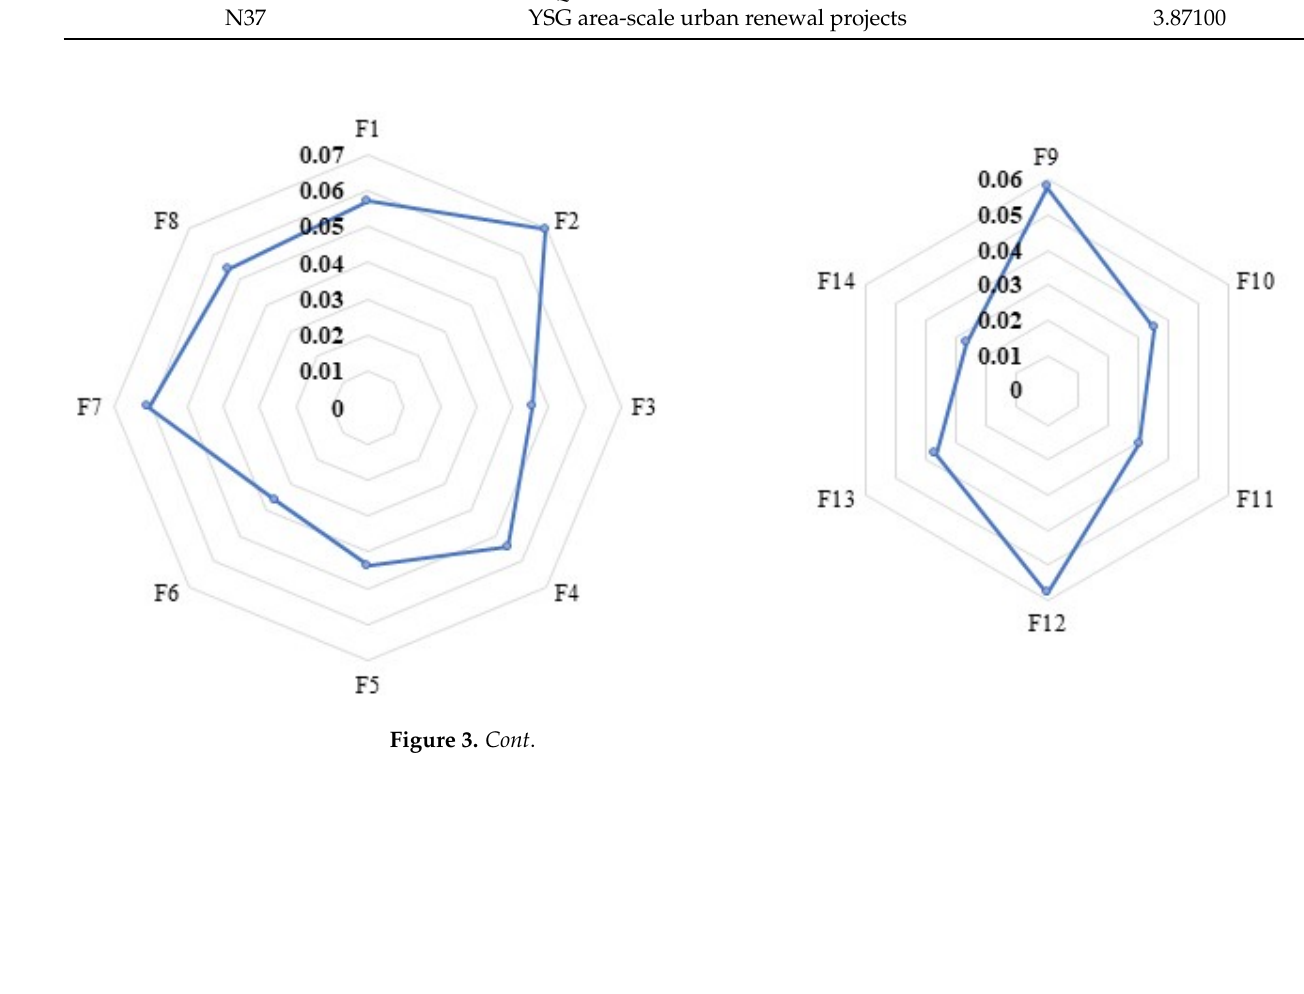
Figure 3. The final weights of each indicator. In summary, through the BP neural network model, the final weight value of the evaluation indicator under each dimension is obtained, and the error is within the control range, indicating that the operation effect of the model is satisfactory. Thus, the BP neural network can optimize the results of the entropy weight method to make its indicator weight results more accurate. The final weight value of the indicator obtained by the BP neural network is used to calculate the final comprehensive benefit values of the renewal initiatives on the area scale, which are summarized in Table 5. Table 5. The final evaluation value of comprehensive benefit. No